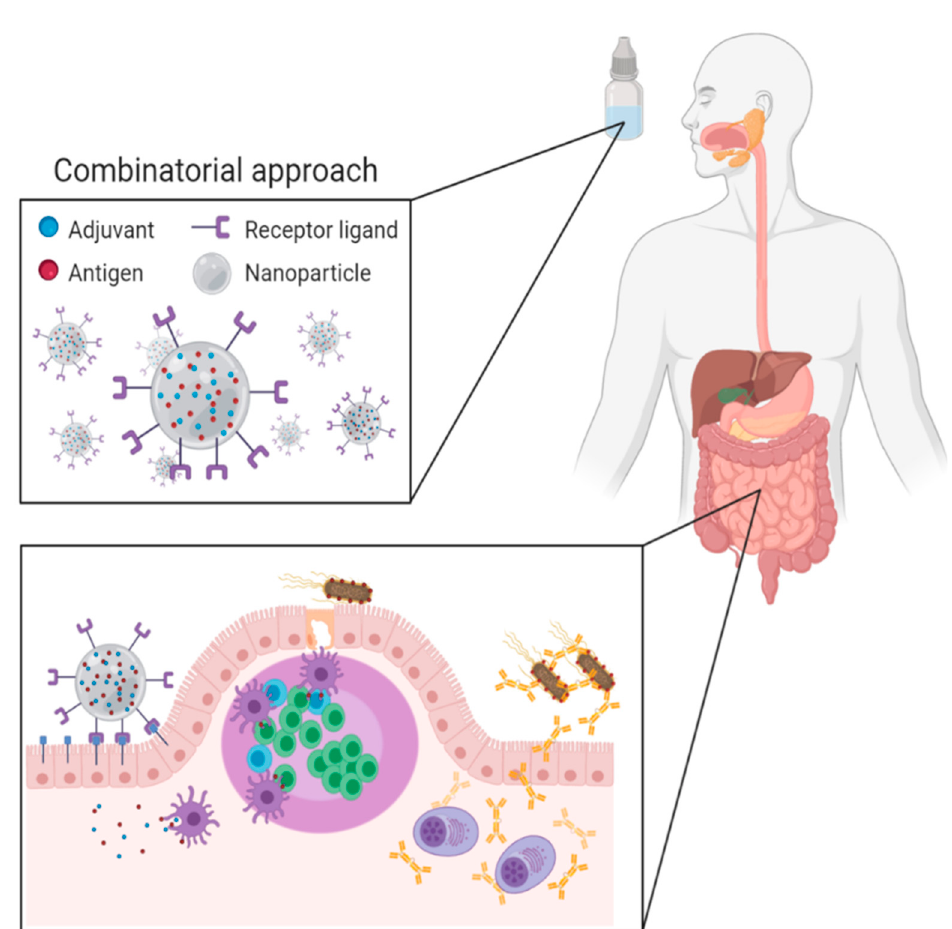
Figure 1. Combinatorial approach for novel oral vaccines: Antigen and adjuvant-loaded, receptor-targeted nanoparticles protect the vaccine antigens from the harsh intestinal environment and mediate the targeted delivery of antigens towards specific intestinal cell populations, thus promoting the induction of mucosal immune responses (Created with BioRender.com).